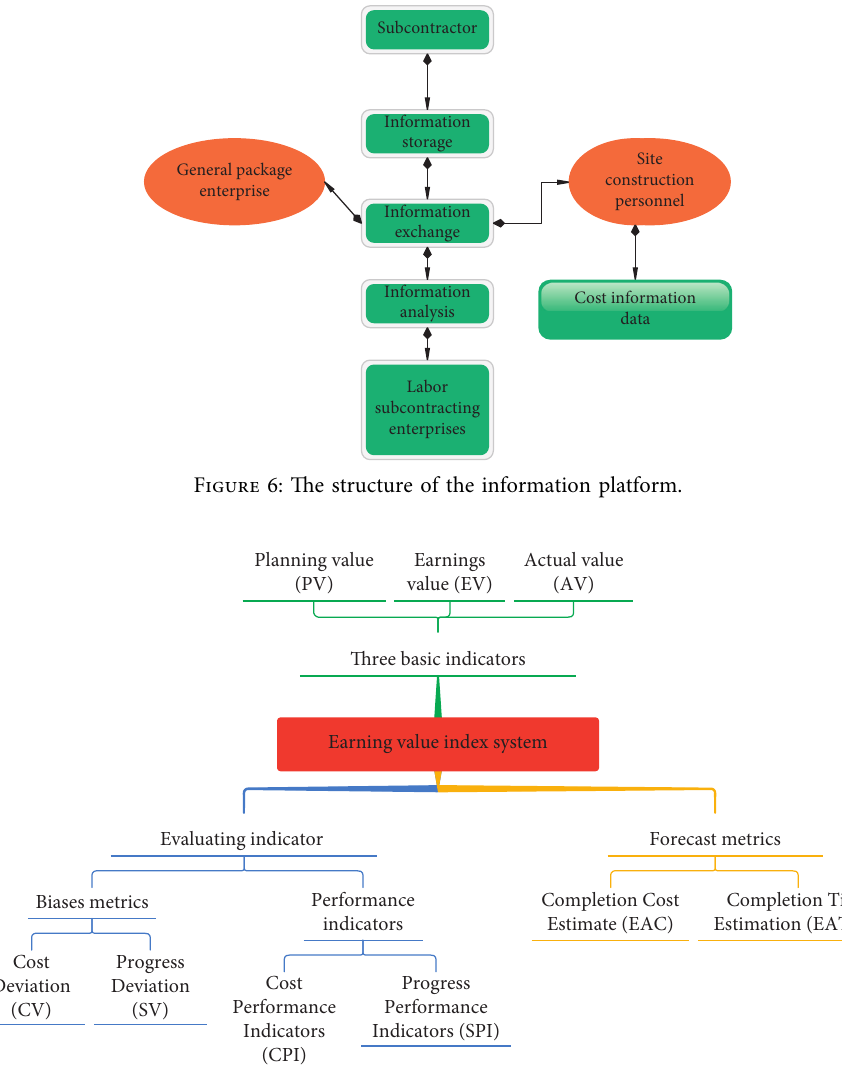
Figure 7: The main parameters of the earned value method.